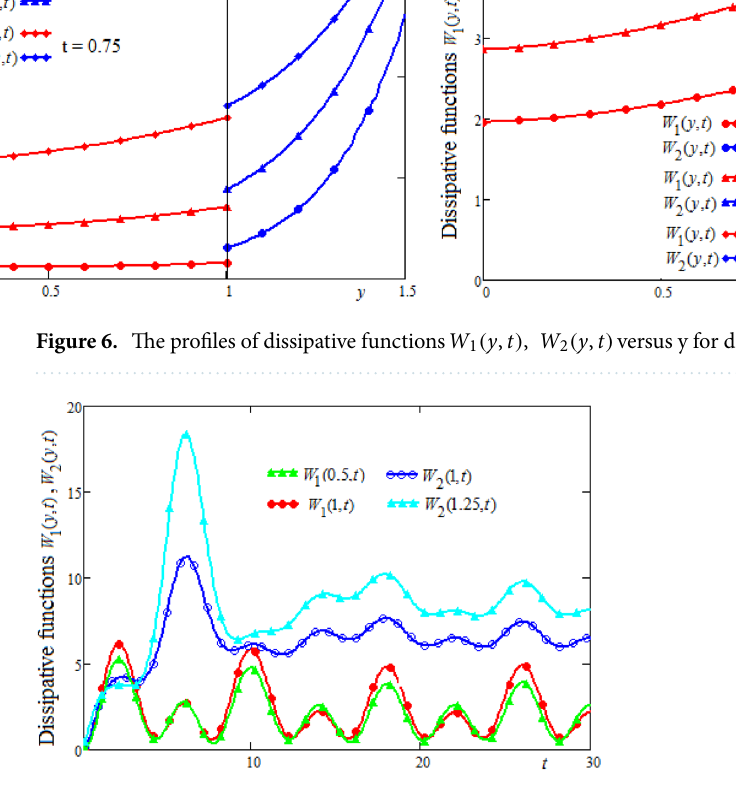
Figure 7. Time-evolution of the dissipative functions W 1 ( y , t ) , W 2 ( y , t ) in three positions of